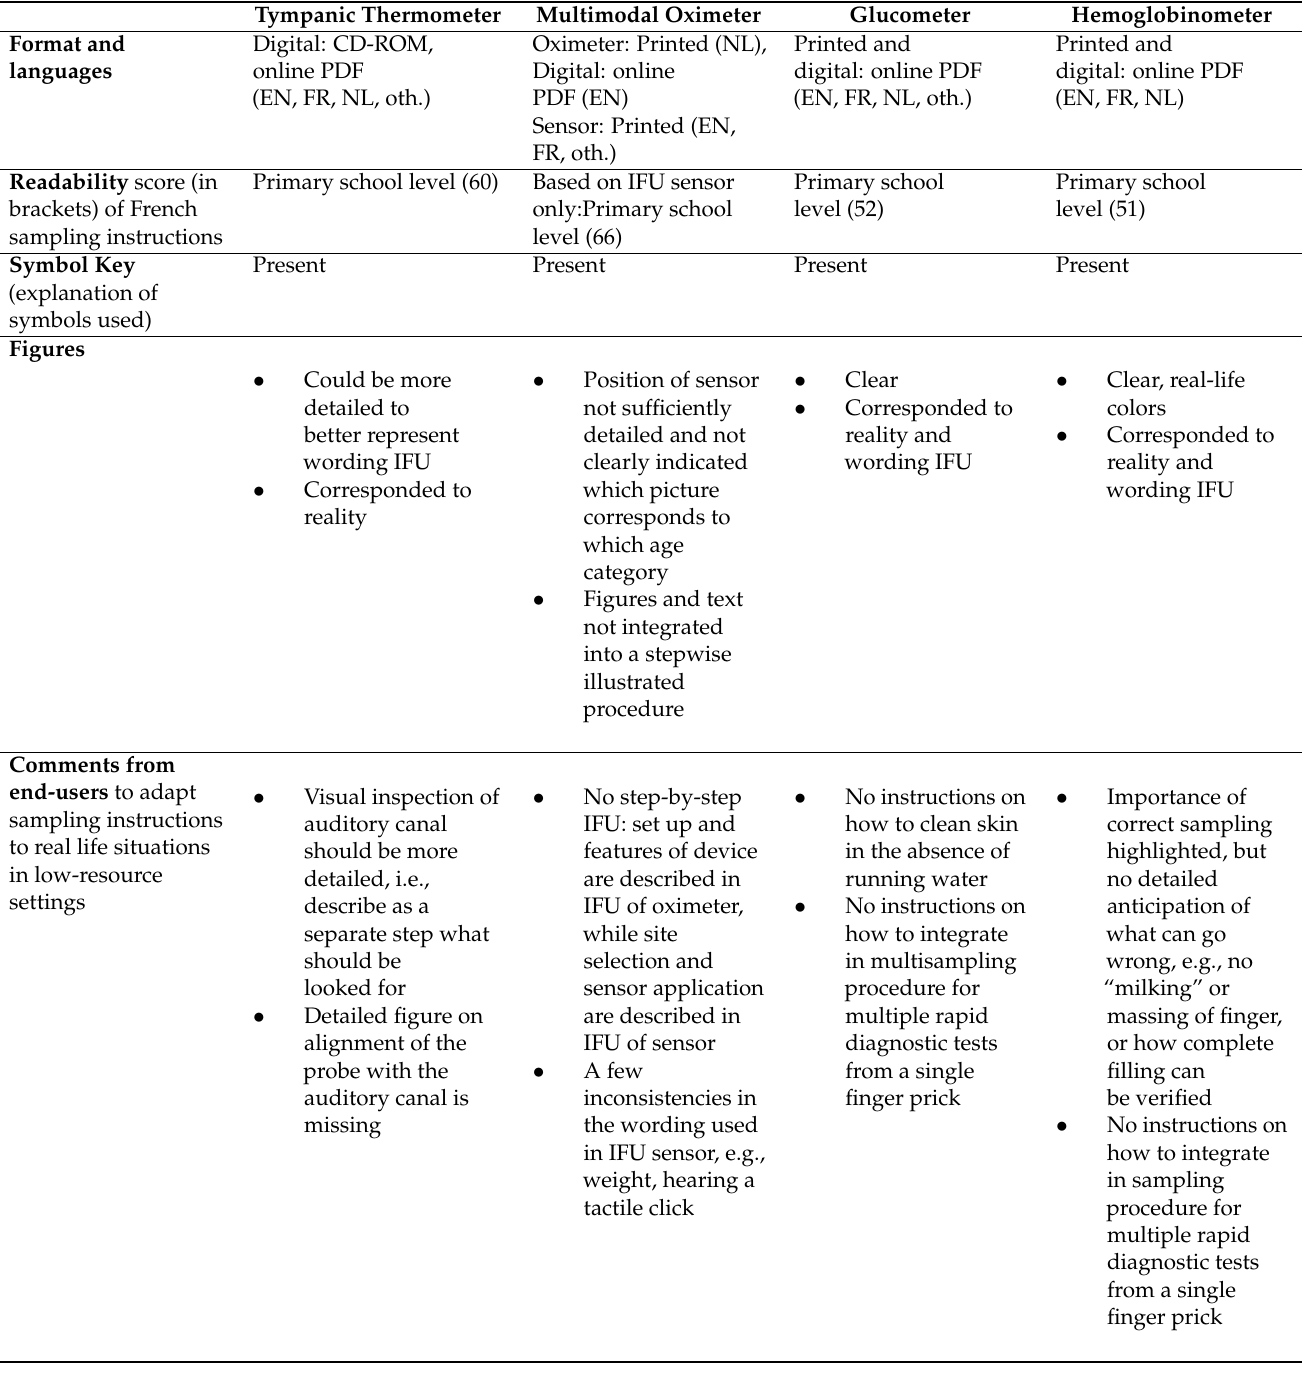
Table 1. Evaluation of instructions for use of handheld diagnostic devices used for hospital triage of children under the age of five with severe febrile illness. Abbreviations: IFU: instructions for use;